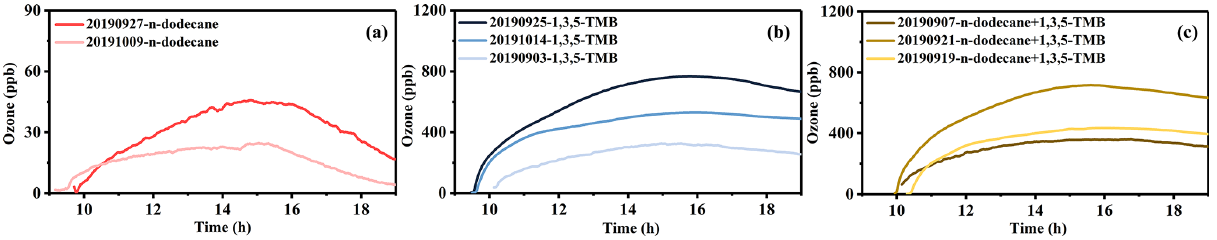
above indicated that the higher TMB / Dod ratio played a de- cisive role in the generation of ozone concentration. Higher temperature and a higher (cid:49) VOC / NO x (ppbC / ppb) ratio in a separate reaction system will promote the generation of ozone; the relative content of reaction precursors (ppb / ppb) in the mixture system will affect the concentration of